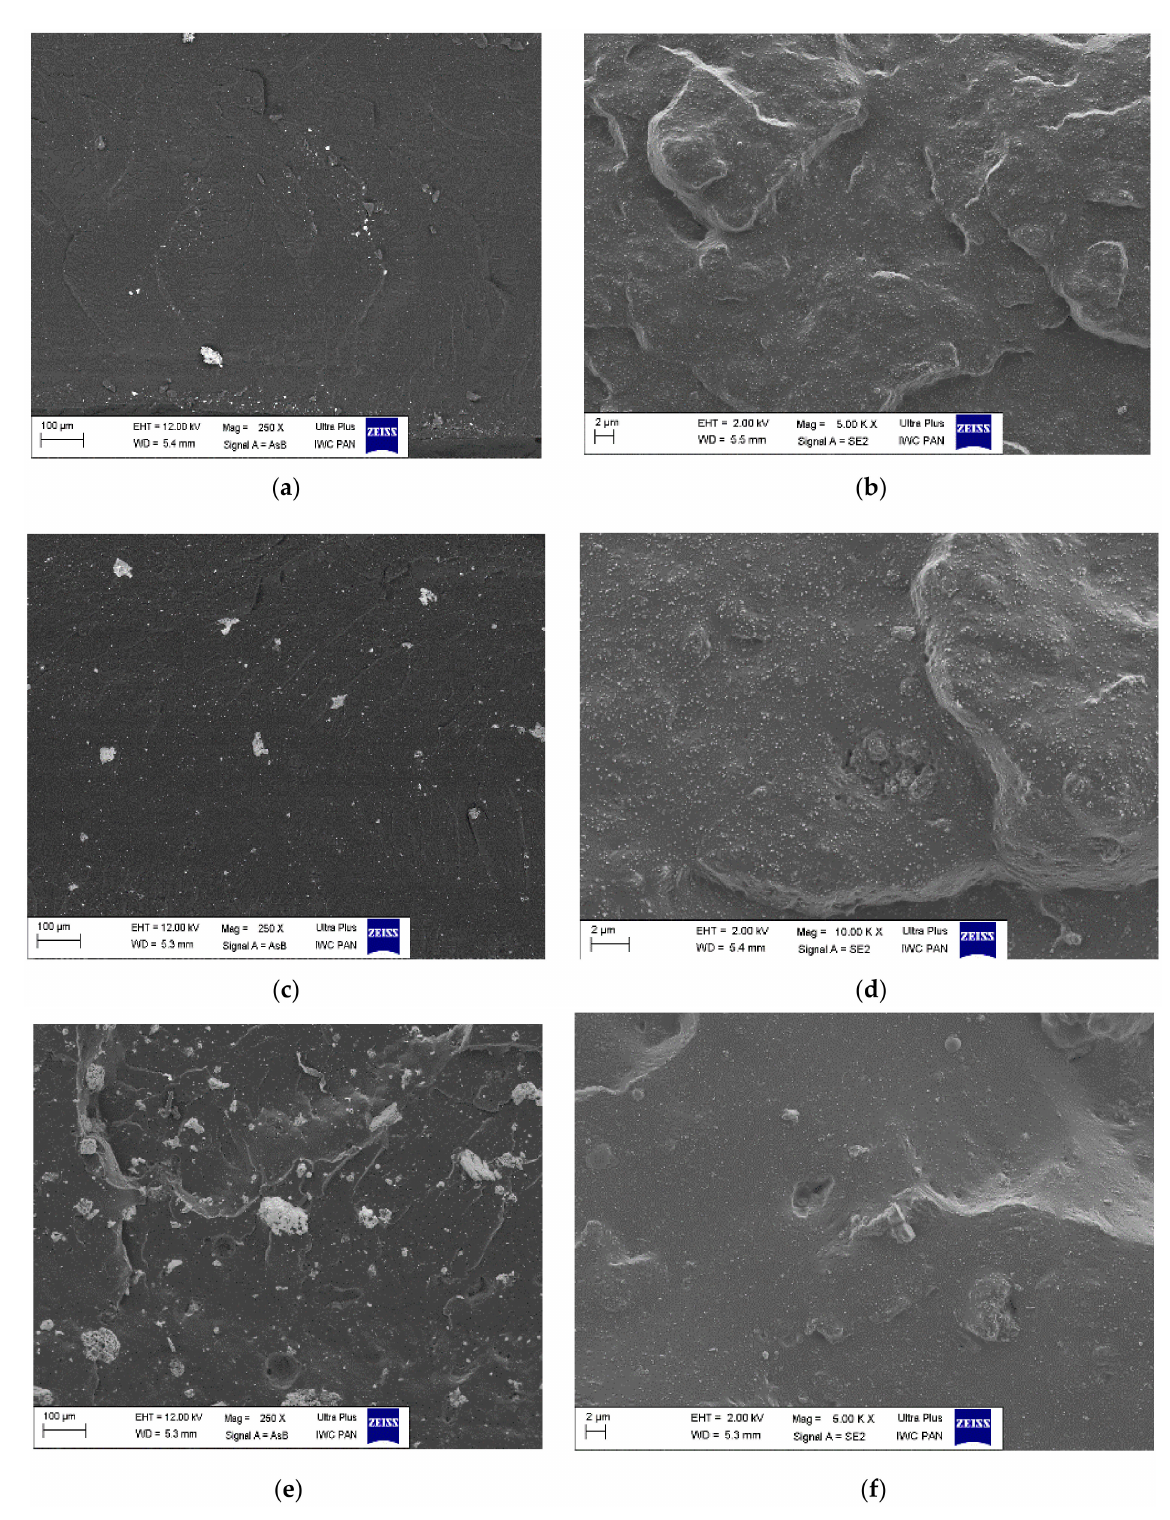
Figure 6. SEM photographs of composites ( a , b )—SBR; ( c , d )—SBR1 (10); ( e , f )—SBR1 (20); left: photographs with × 250 magnification, right: photographs with × 5000